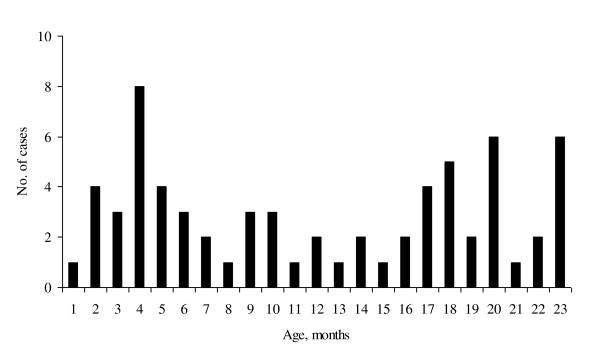
Age distribution of intussusception in 67 children aged <24 months, Bukhara region, Uzbekistan, 2004-2008.